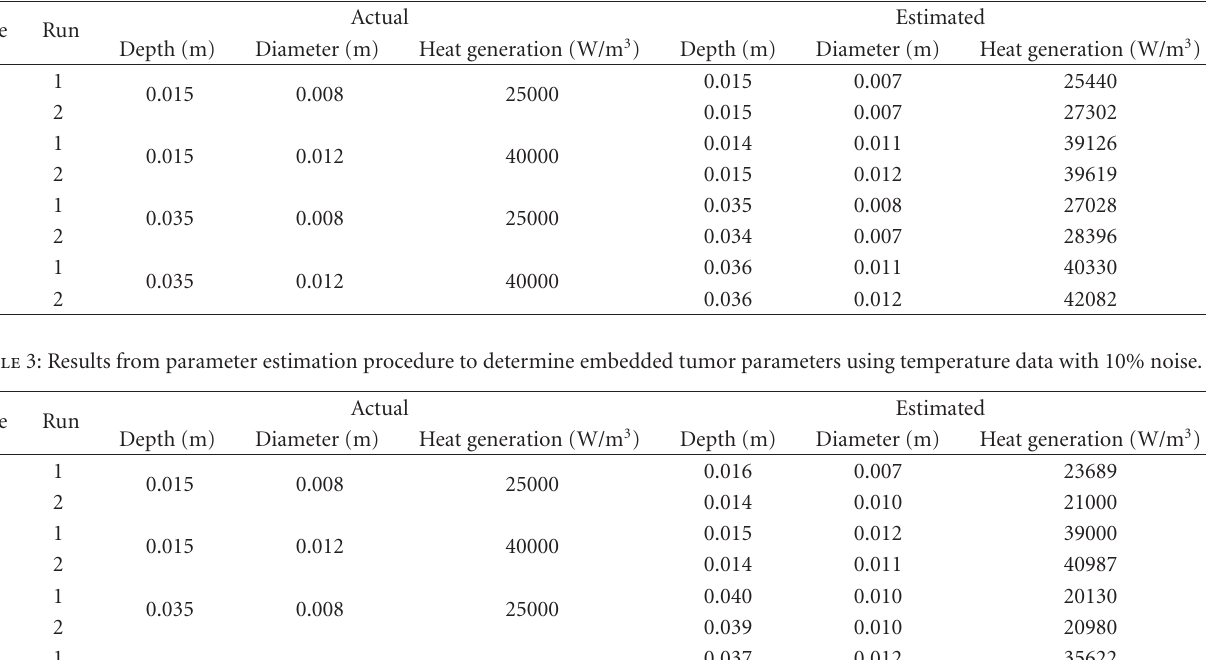
Table 2: Results from parameter estimation procedure to determine embedded tumor parameters using temperature data with 5% noise. Case